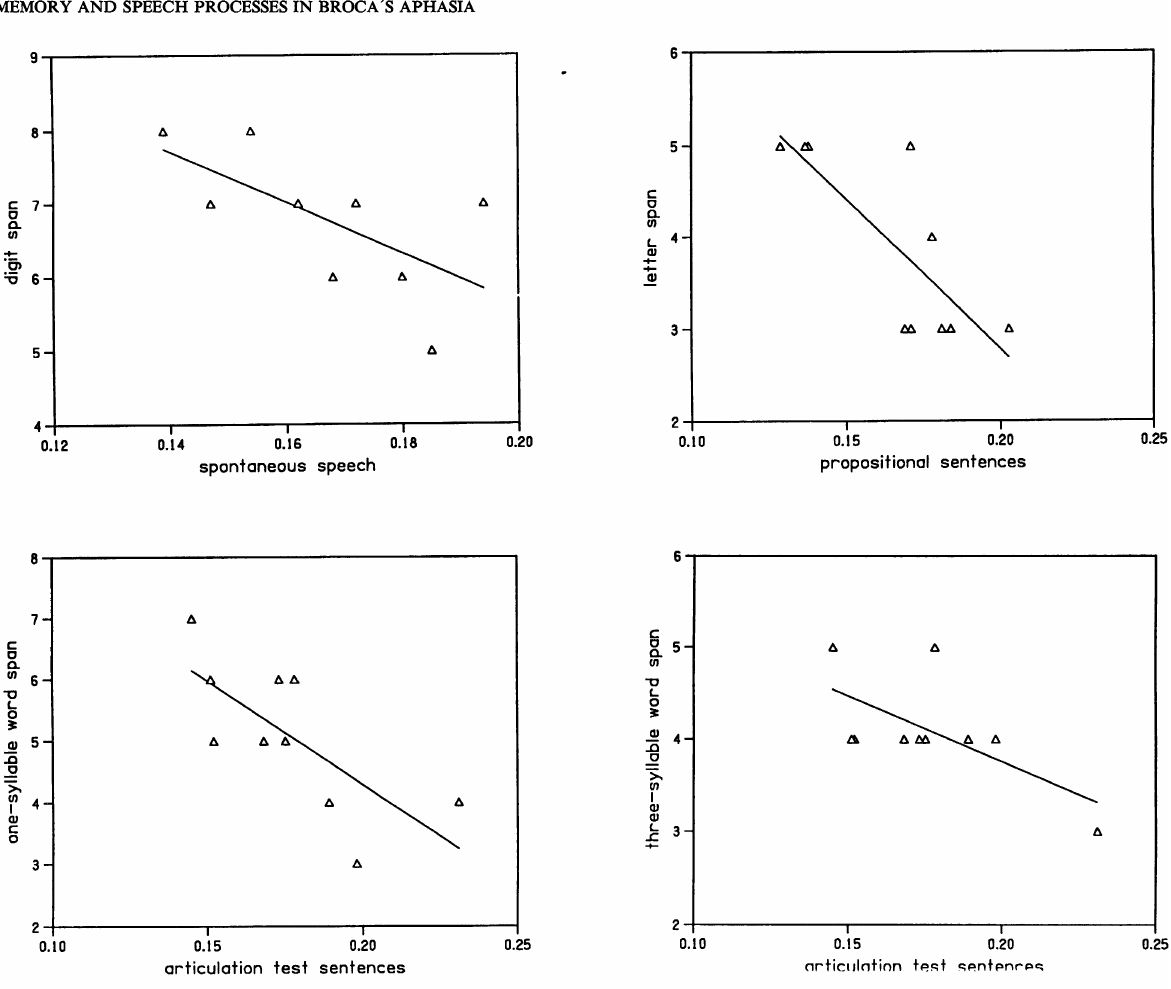
FIG. 5. Relationship between several memory spans and speech rate scores. In all graphs, speech rate is expressed in terms of mean syllable duration